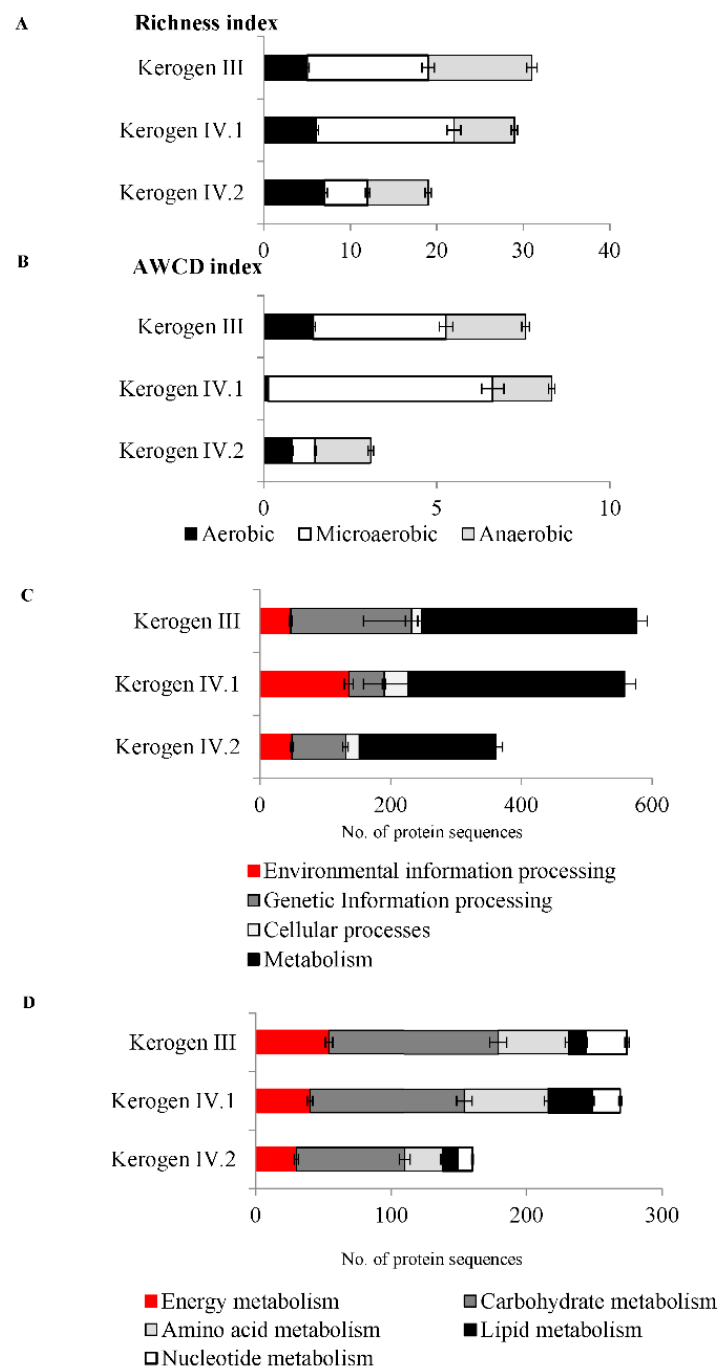
Figure 4. Activity and general characteristics of metaproteomes of the three bacterial communities identified in the shale rock samples enriched in kerogen III, IV.1, and IV.2 samples. Metabolism profile of organic carbon expressed as richness index ( A ) and average well color development (AWCD) index ( B ) under aerobic, microaerobic, and anaerobic conditions. Number of protein sequences detected in metaproteomes, classified into functional categories ( C ) and main categories of metabolism ( D ). The error bars represent standard deviation.